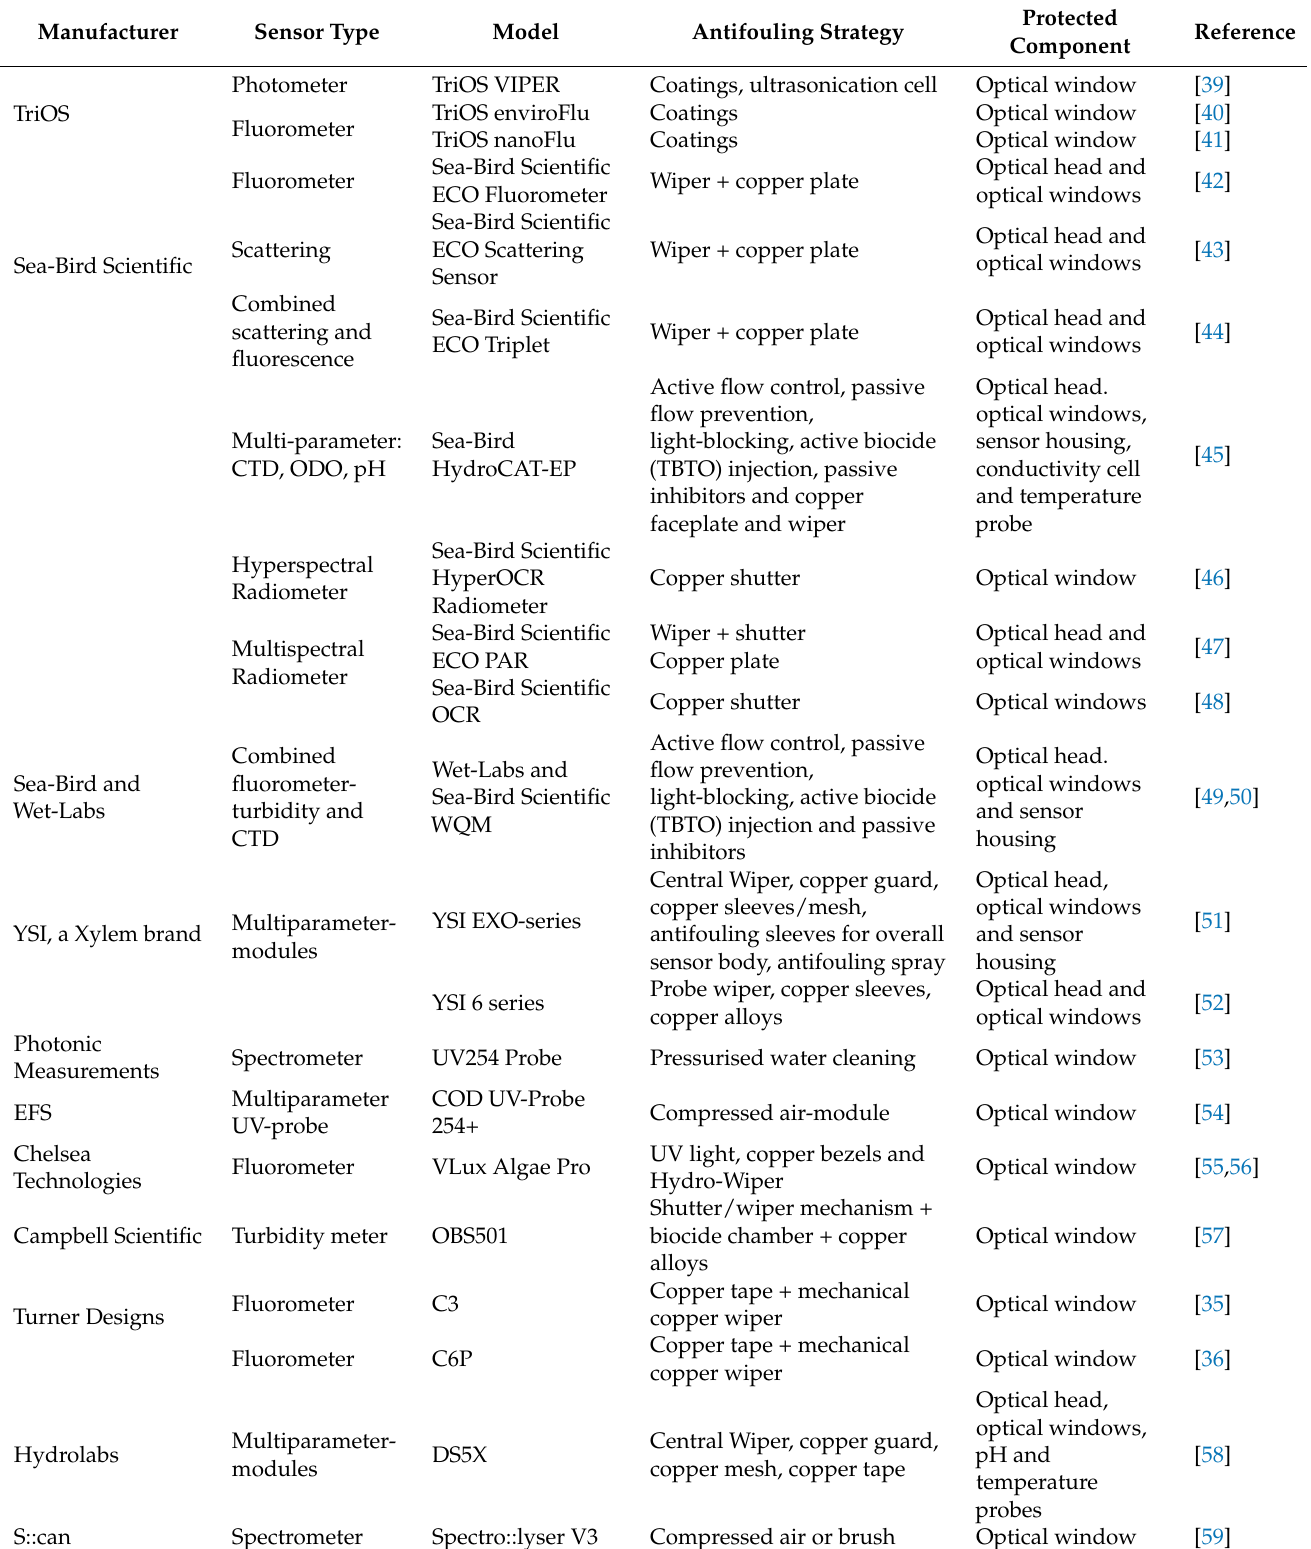
Table 2. Antifouling strategies implemented by sensor